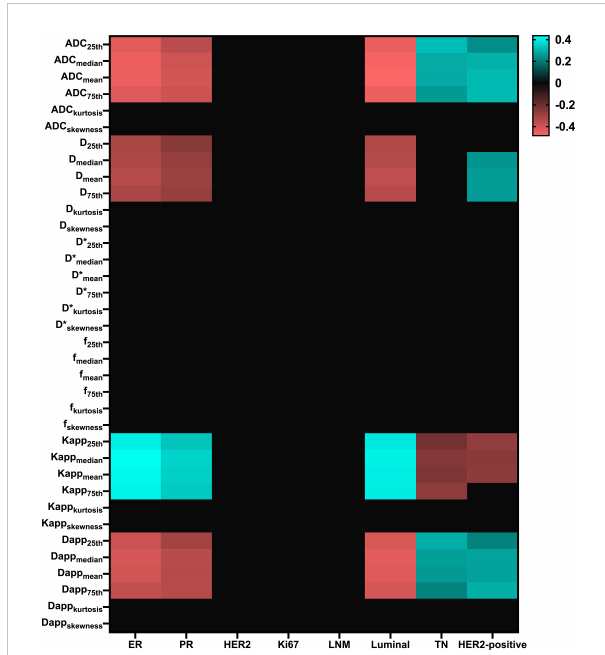
FIGURE 1 Matrix plot of the Pearson correlation coef fi cients between multi- model histogram parameters with molecular prognostic factors and subtypes. Colored entries indicate signi fi cant correlations (p<0.0625) with positive (blue) or negative (red). ER, Estrogen receptor; PR, Progesterone receptor; HER2, Human epidermal growth factor receptor 2; LNM, Lymph nodes metastasis; TN, Triple-negative.; D*, pseudo-diffusion coef fi